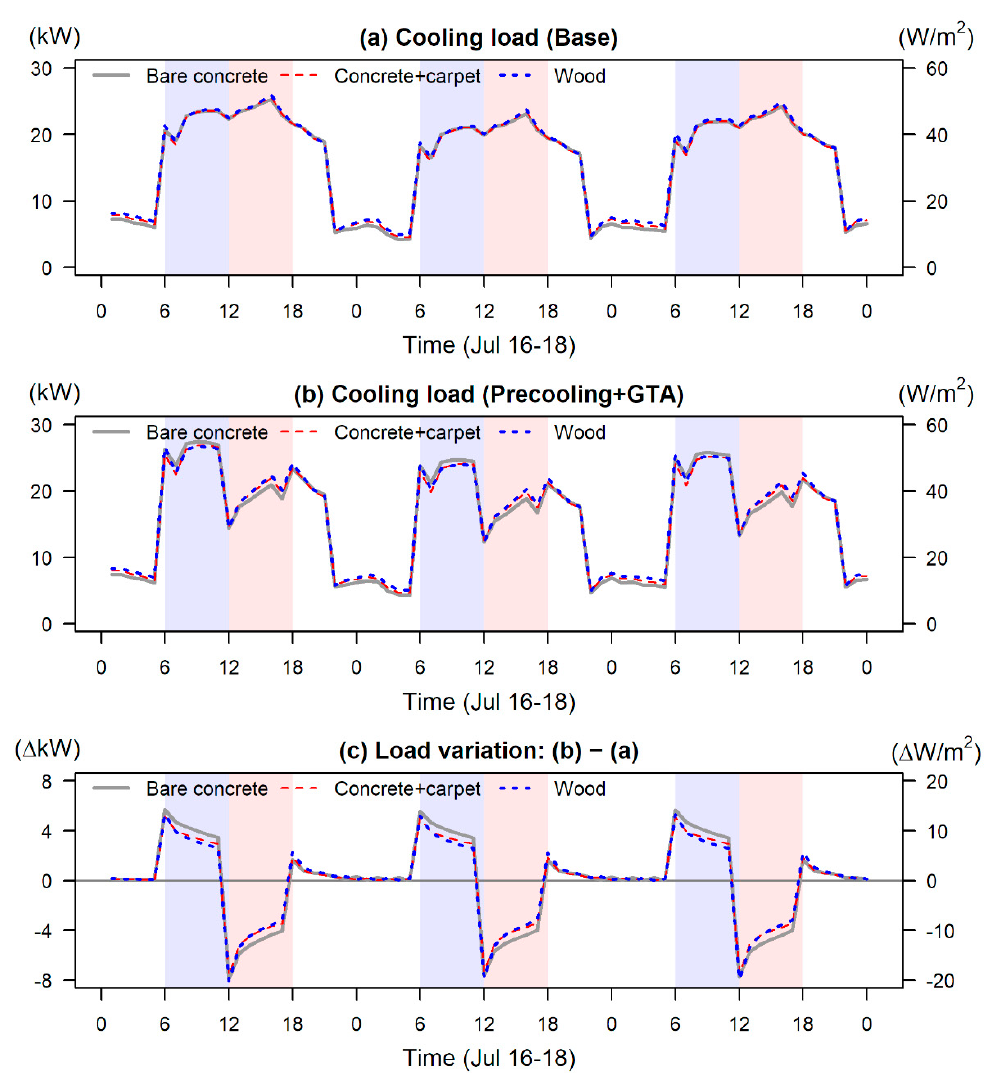
Figure 5. Hourly cooling loads for three floor configurations: Bare concrete, Concrete + carpet, and Wood under ( a ) Base and ( b ) Precooling + GTA scenarios, and ( c ) variations in hourly cooling loads between the two scenarios during 16–18 July in Phoenix, AZ. The blue-shaded area indicates the morning or precooling period while the red-shaded area indicates the afternoon or GTA period.